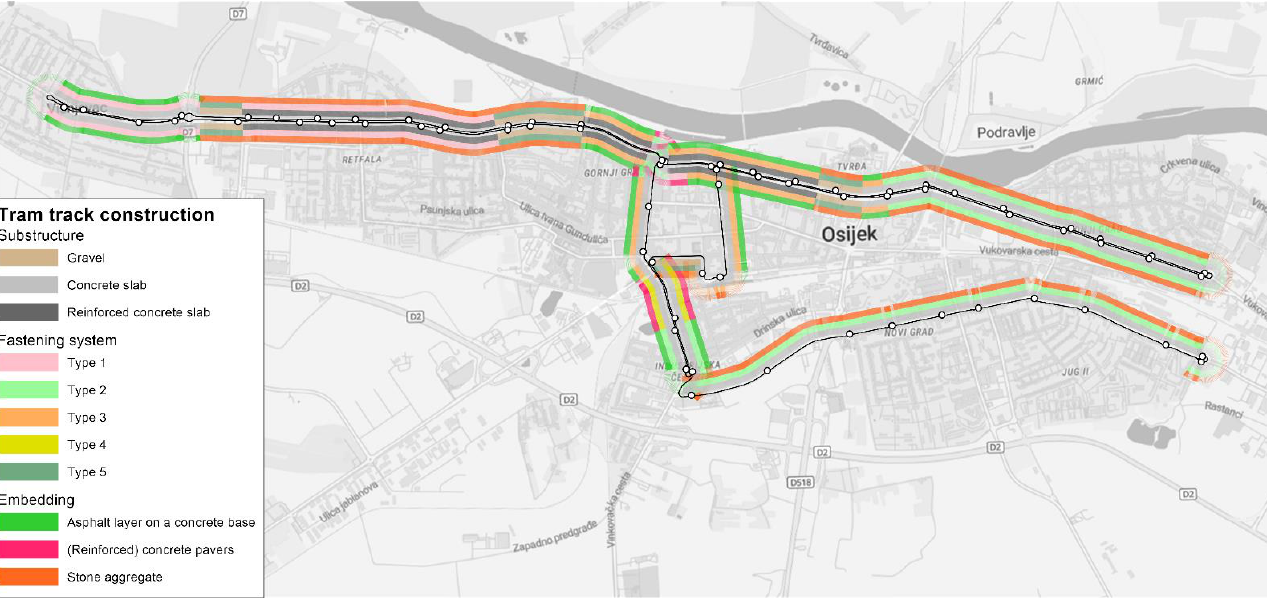
Figure 2. The City of Osijek tram-track construction elements.